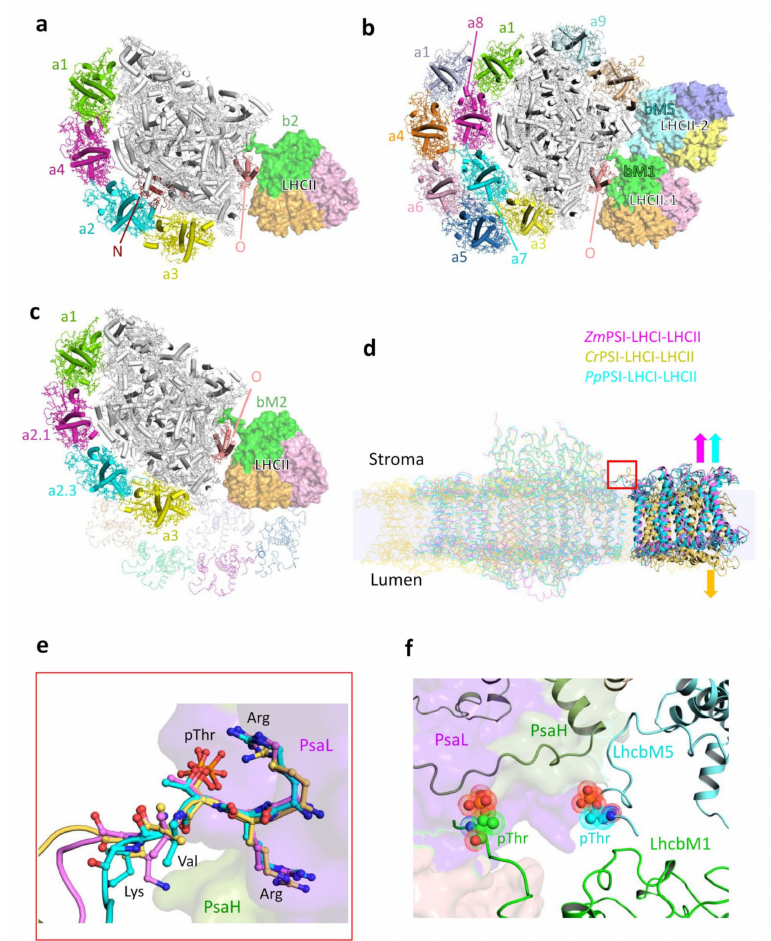
Figure 3. Structures of PSI–LHCI–LHCII from plants and green algae. ( a ), Overall structure of Zm PSI–LHCI–LHCII (PDB code: 5ZJI). ( b ), Overall structure of Cr PSI–LHCI–LHCII (PDB code: 7DZ7). ( c ), Modeled Pp PSI–LHCI–LHCII on the basis of the Pp PSI-L structure (PDB code: 8HTU). The PSI–LHCI parts are displayed as a cartoon, with Lhcas, PsaO and Zm PsaN shown in different colors and labeled. The other core subunits are shown in white. The LHCII trimers are displayed as a surface and distinguished by different colors. The Lhcb9 and Lhca proteins in the outer LHCI belt from Pp PSI-L which are not included in the modeled Pp PSI–LHCI–LHCII are shown as a ribbon in ( c ). ( d ), Comparison of the membrane-spanning regions of the three PSI–LHCI–LHCII complexes. LHCIIs ( Cr LHCII-1) are displayed as a cartoon, and other parts are shown as a ribbon. Zm PSI–LHCI–LHCII, Cr PSI–LHCI–LHCII and modeled Pp PSI–LHCI–LHCII are displayed in magenta, yellow and cyan, respectively. Arrows indicate the deflection of LHCII relative to the membrane. The phosphorylated N-terminal regions of LHCIIs are highlighted in a red box. ( e ), Structural comparison of the first five residues from Zm Lhcb2, Cr LhcbM1 and Pp LhcbM2. ( f ), Zoomed-in view of the binding sites of the N-terminal regions of Cr LhcbM1 and Cr LhcbM5 in Cr PSI–LHCI–LHCII. The phosphorylated Thr residues are highlighted with